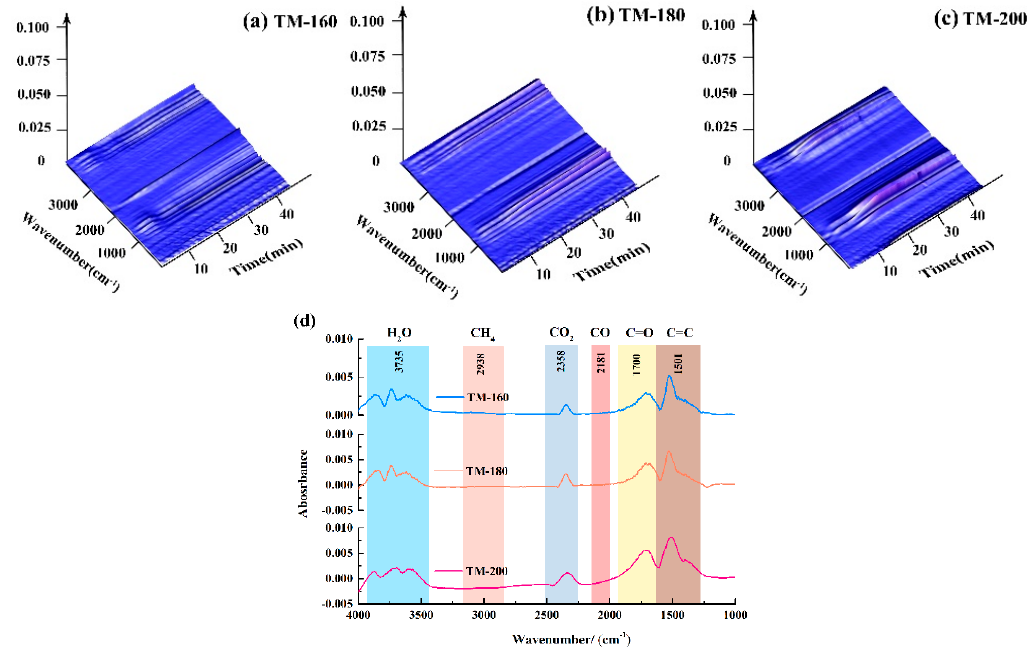
Figure 10. 3D-FTIR analysis of wood thermal modification at different temperatures: ( a ) 3D-FTIR of TM-160; ( b ) 3D-FTIR of TM-180; ( c ) 3D-FTIR of TM-200; ( d ) 2D-FTIR at the points of maximum weight loss from the three thermal modification samples.